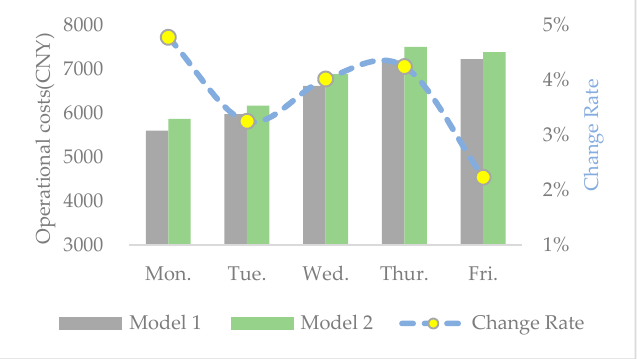
Figure 7. Operational costs and change rate in the two models.